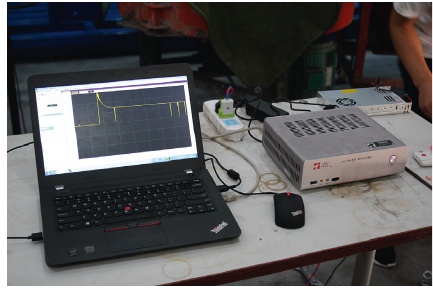
Figure 6: Data collection